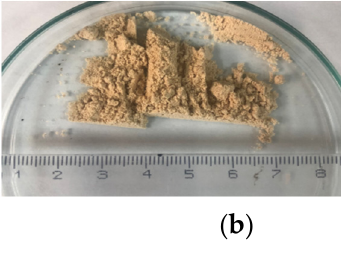
Figure 1. Appearance of JA ( a ) and PI ( b ) particles.